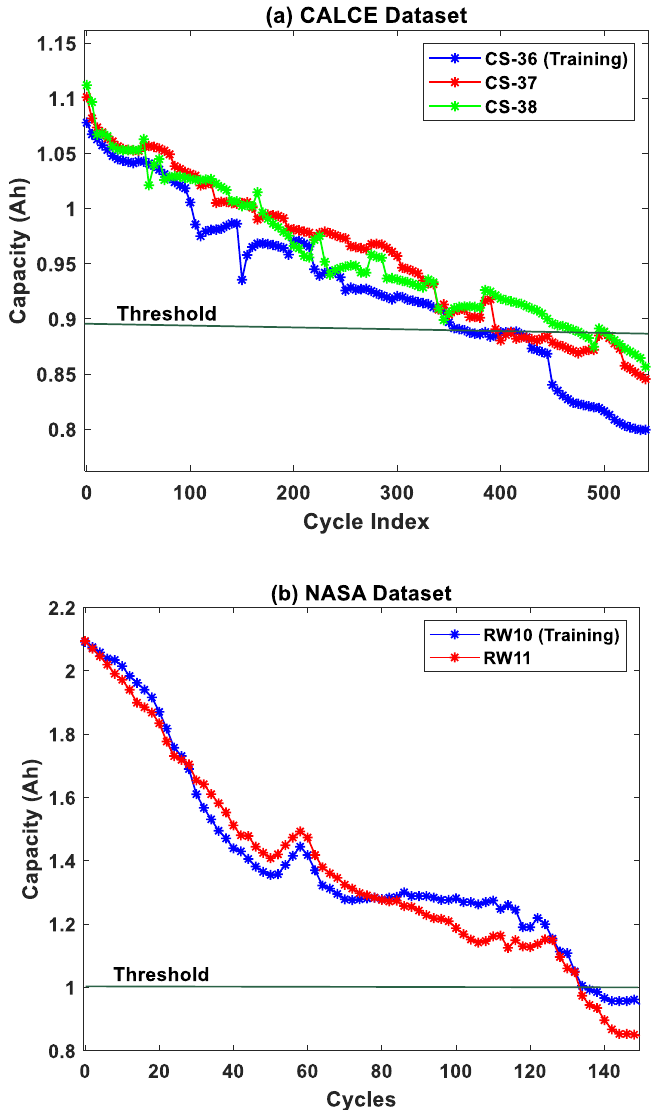
Figure 1. The battery capacity degradation datasets from the ( a ) CALCE and ( b ) NASA